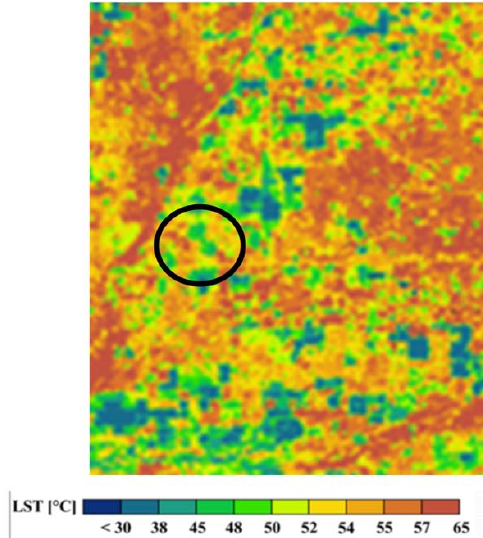
Figure 3. Surface temperature image at 10:30 a.m. on 11 May 2014. Study area is circled.